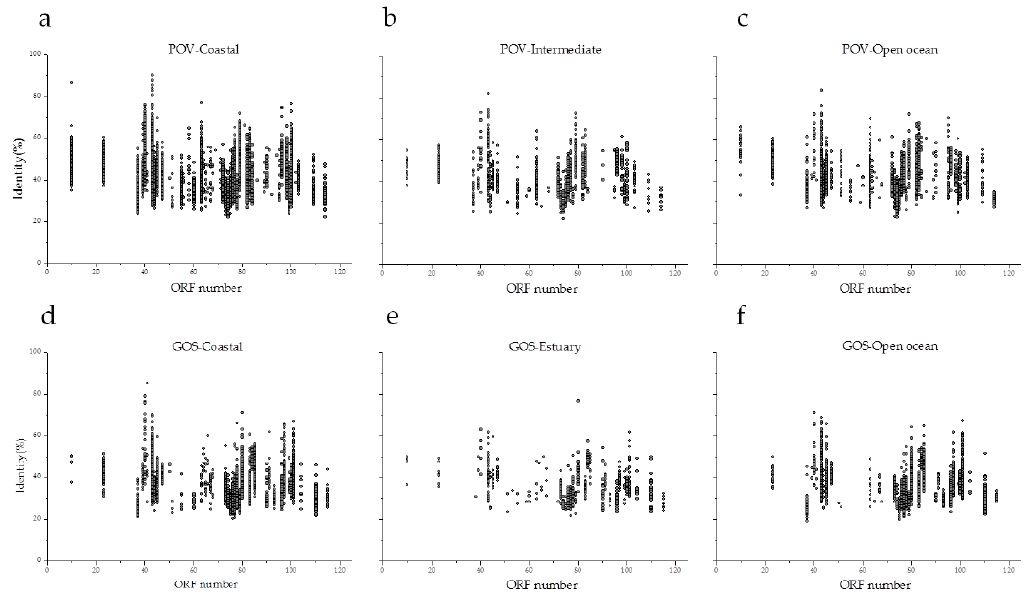
Figure 6. Prevalence of R5C-like ORFs in environmental viral metagenomic data. ( a ) Coastal metagenomes of POV; ( b ) Intermediate metagenomes of POV; ( c ) Open ocean metagenomes of POV; ( d ) Coastal metagenomes of GOS; ( e ) Estuary metagenomes of GOS; ( f ) Open ocean metagenomes of GOS.